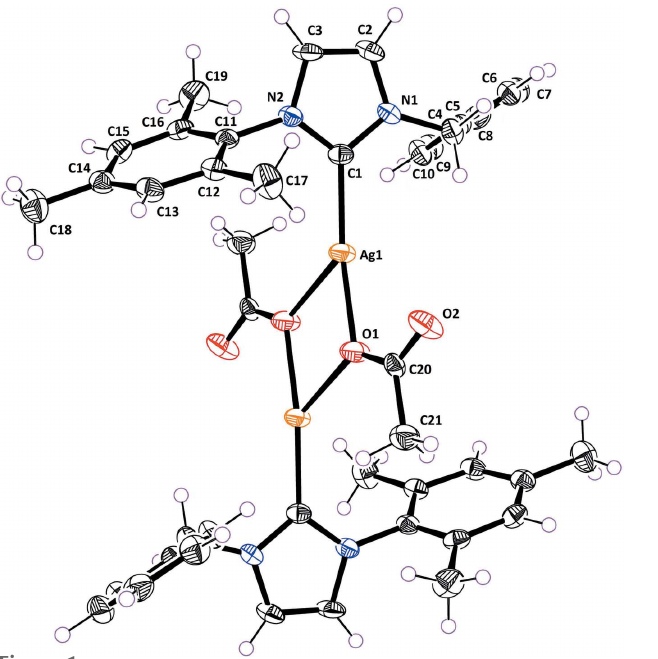
Figure 1 Molecular structure of 2 , with displacement ellipsoids drawn at the 50% probability level.